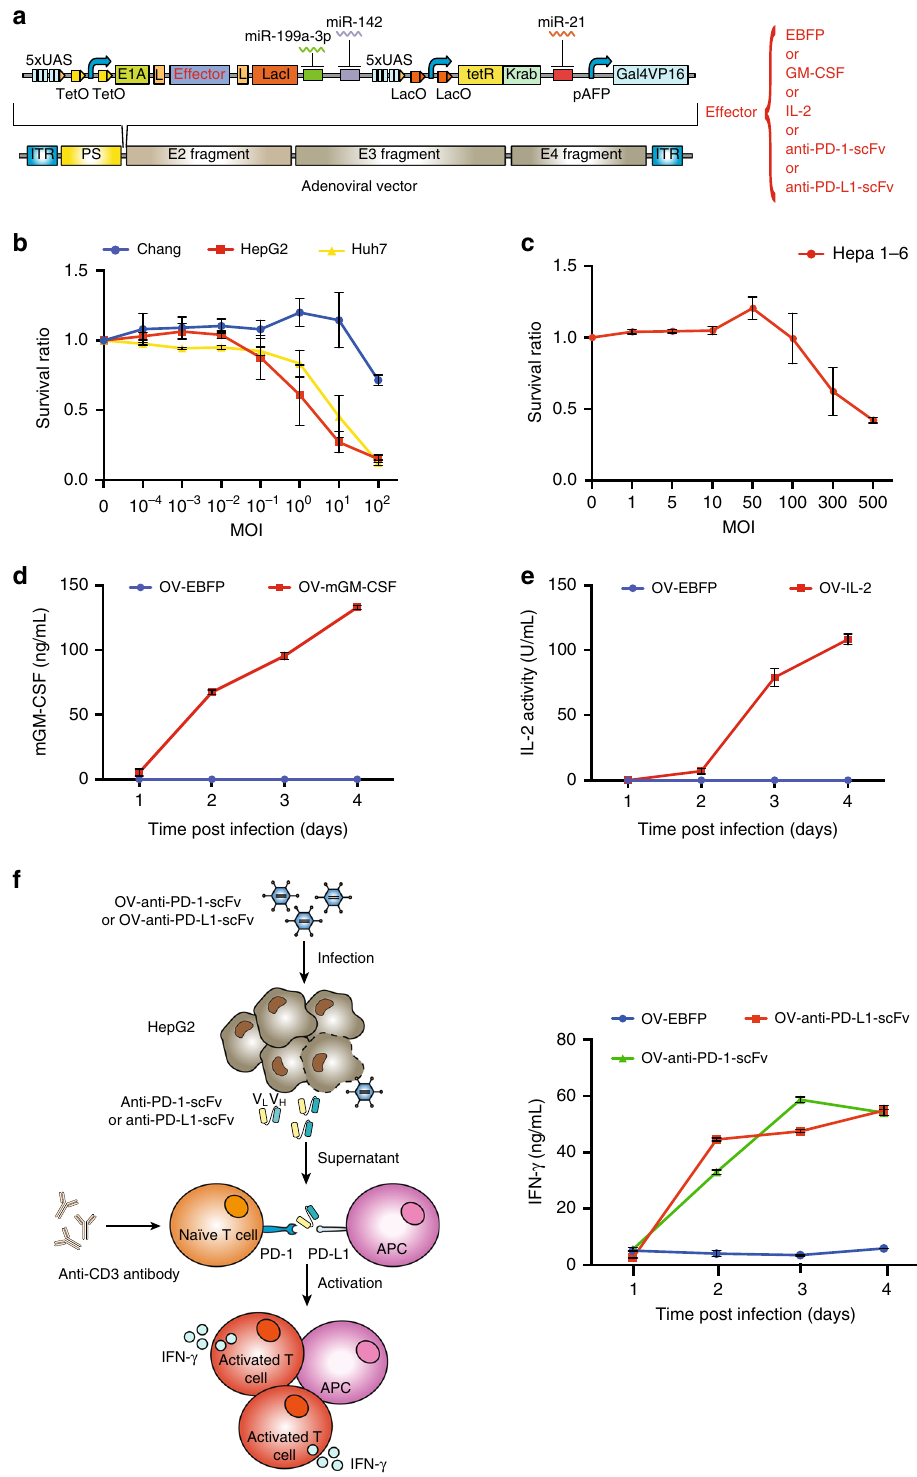
Fig. 4 Functional assay of synthetic oncolytic adenovirus in vitro. a The schematic diagram of adenoviral genome loaded with sensory switch circuit encoding different immune effectors (OV-Effector). The survival ratios of different human HCC cells in Panel b and mouse Hepa1-6 cells in Panel c were measured by using MTS cell viability assay 6 days after incubation with indicated amount of OV-EBFP. Data are shown as mean ± s.d. from three independent replicates. d – f 3 × 10 6 HepG2 cells were incubated with 10 MOI of oncolytic adenovirus encoding indicated immune effectors for 4 days and the supernatants were collected for measurement of mGM-CSF production by using ELISA in ( d ), or the bioactivity of IL-2 by using MTS proliferation assay on cytokine-dependent cell line CTLL-2 in ( e ), or the bioactivity of anti-PD-1-scFv and anti-PD-L1-scFv by using ELISA in mouse splenocyte system in the presence of anti-CD3 antibody in ( f ). Data are shown as mean ± s.d. from three independent replicates. Source data are provided as a Source Data fi